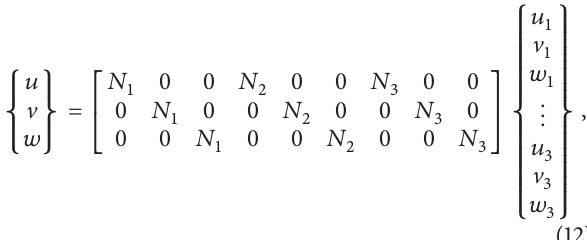
Figure 13: Effect of tolerance on the element selection. If the path node falls in the tolerance domain, Elements I and II and others may be selected.